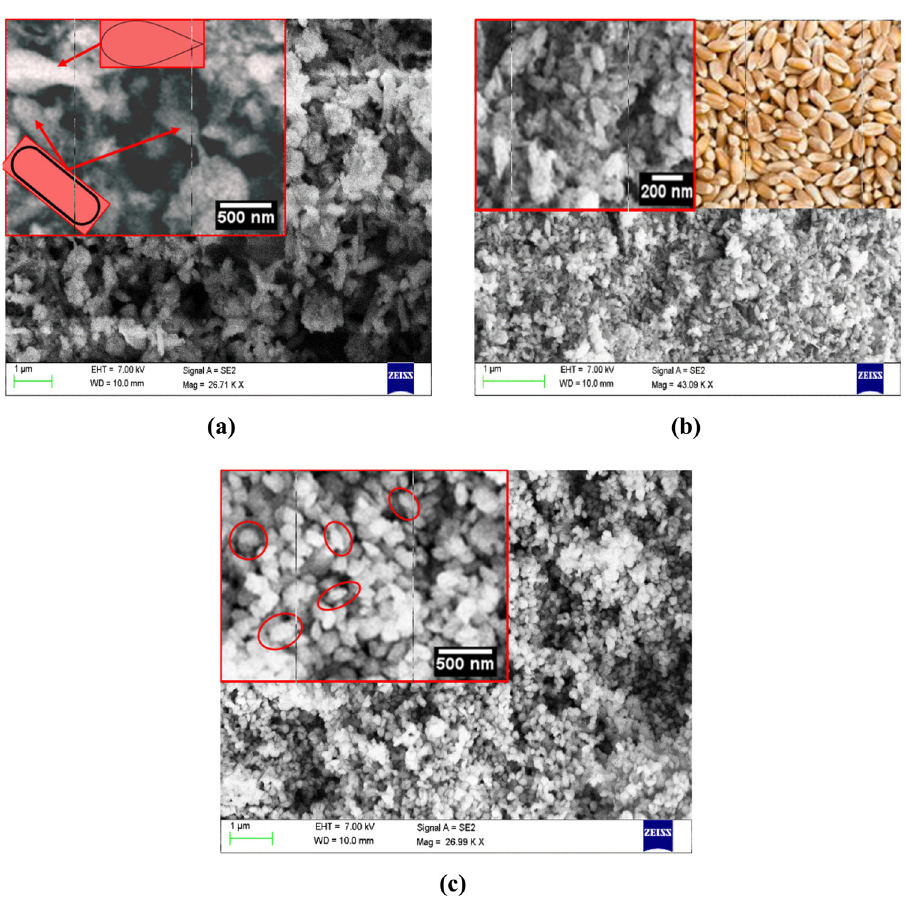
Figure 26: SEM images of CuO NPs created from various copper acetate monohydrate concentrations. Copied with permission from ref. [ 299 ] ; Elsevier, 2021. ( a ) [ Cu ( CH